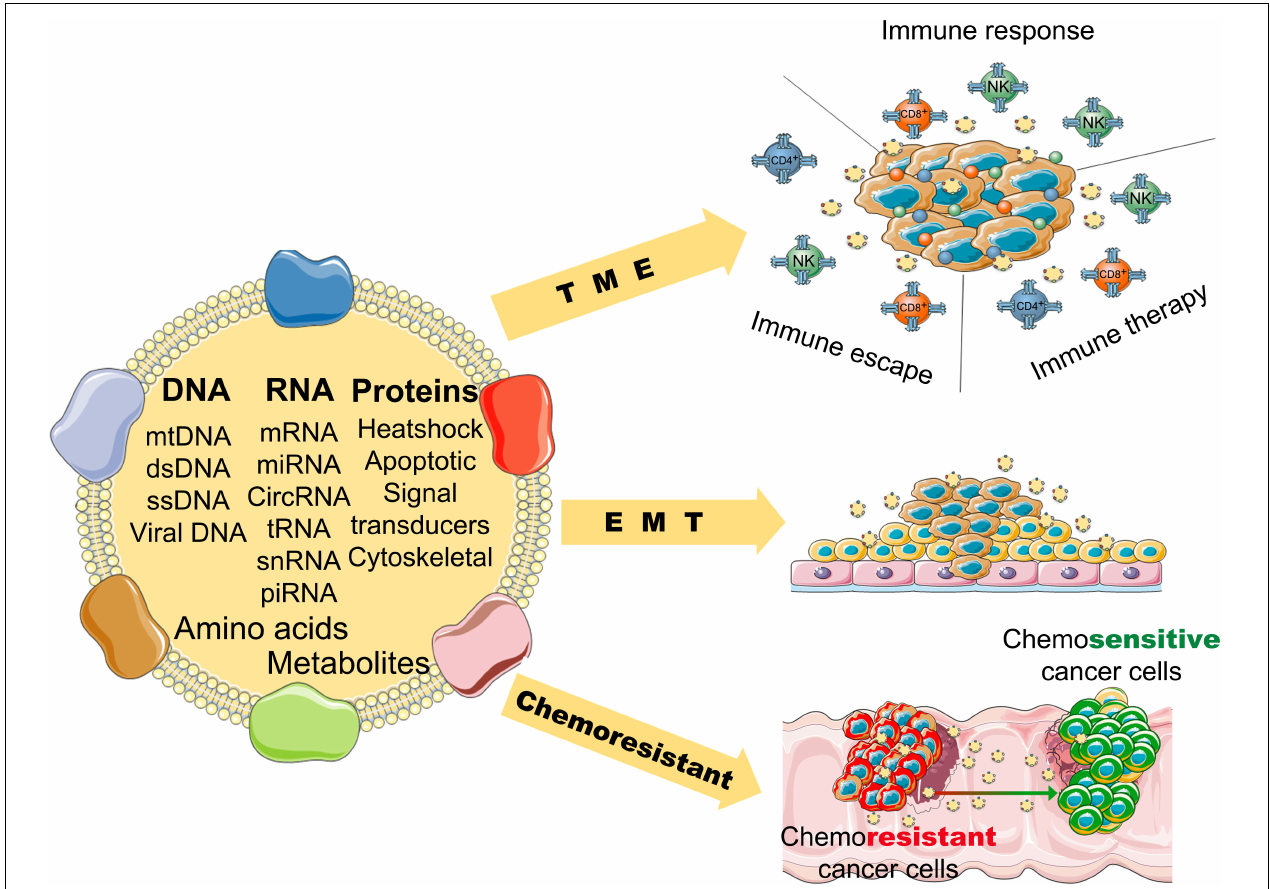
FIGURE 2 | The potential role of tumor-derived exosomes in the progression and pathological process of cancer (TME, tumor microenvironment; EMT, epithelial-mesenchymal